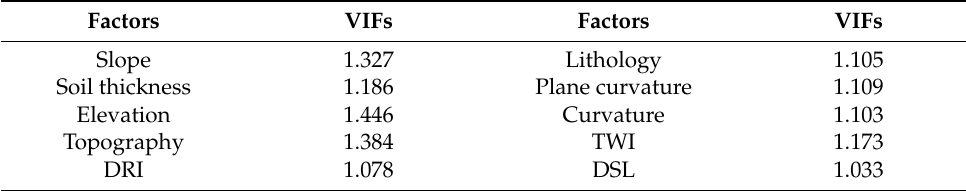
Table 2. Variance inflation factors (VIFs) of the 10 factors.